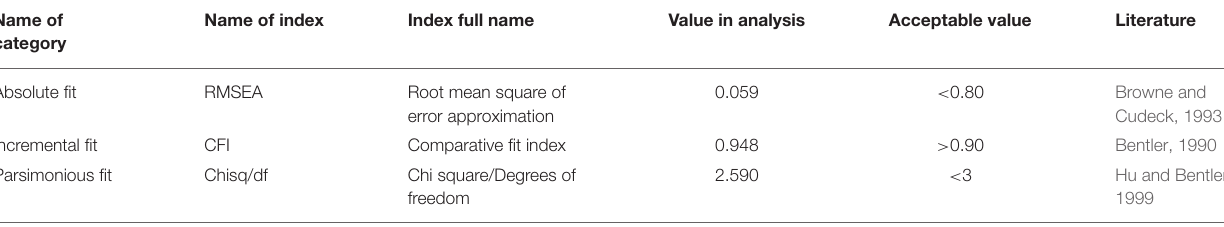
TABLE 2 | Pooled confirmatory analysis model fitness tests.